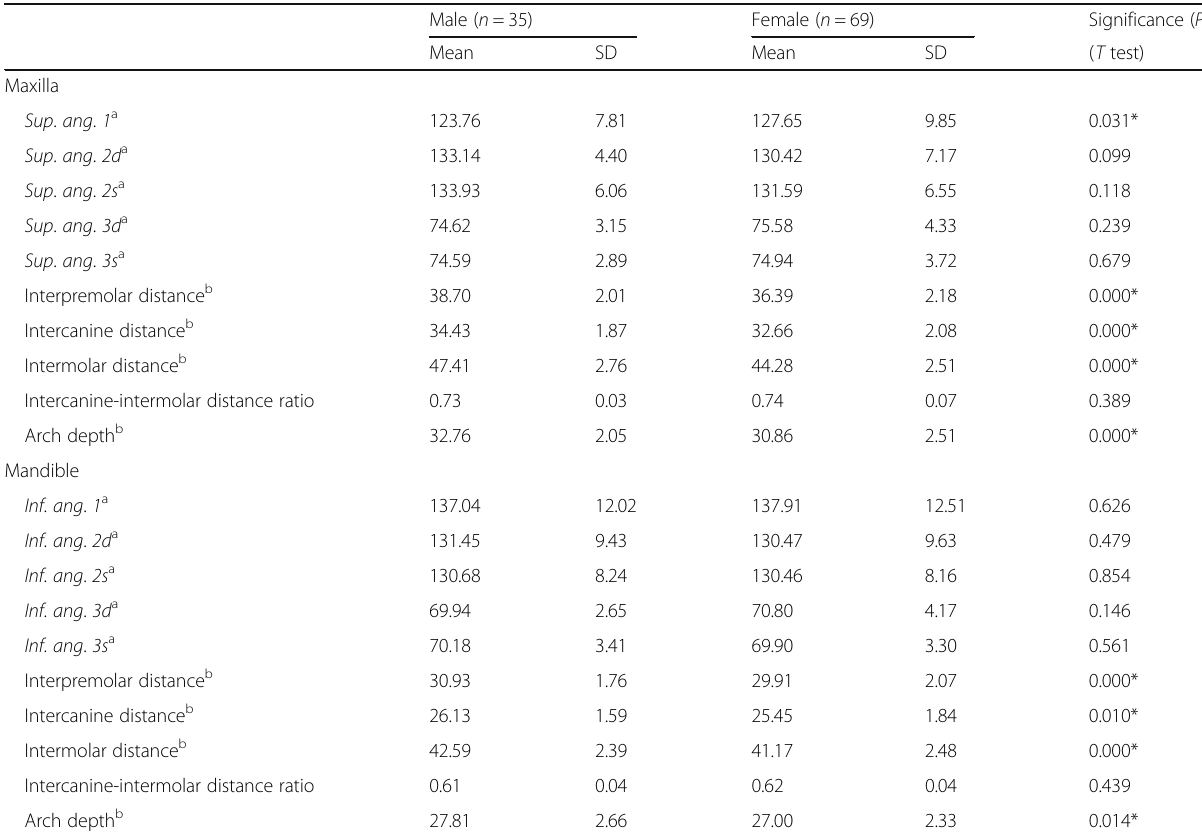
Table 2 Mandible and maxilla T test between male and female